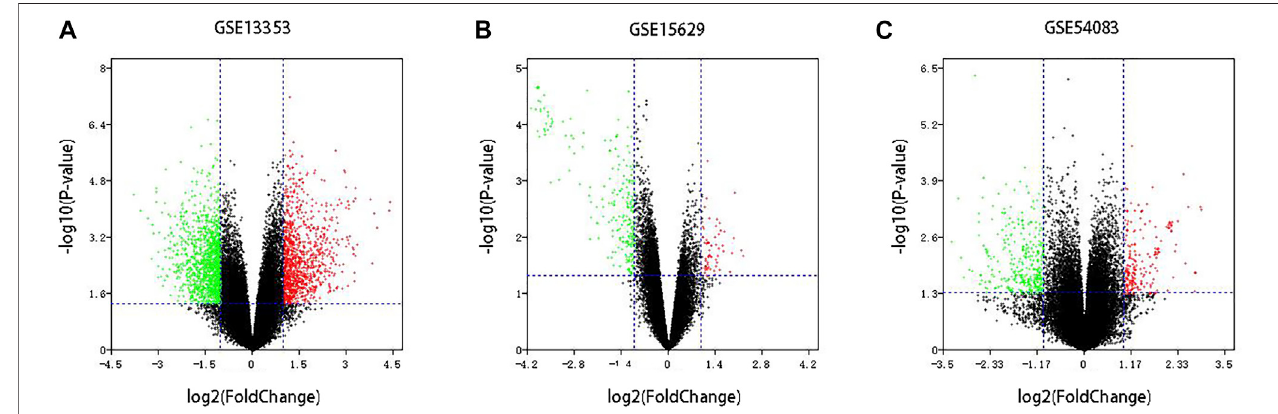
FIGURE 1 | Volcano plot of DEGs among each GEO dataset. (A – C) Three GEO datasets.Red: up-regulated DEGs; Green: down-regulated DEGs; Black: unchanged genes.